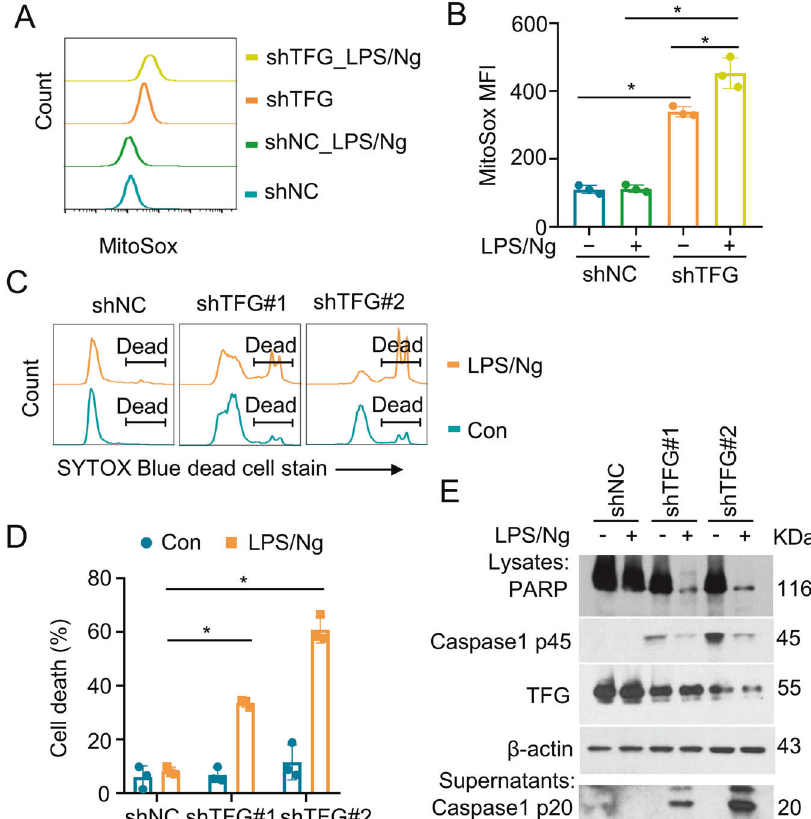
Fig. 1 TFG de fi ciency promotes mitochondrial ROS production and LPS/Ng-induced pyroptosis in THP-1 cells. A THP-1 cells were transduced with a nontargeting control shRNA (shNC) or TFG-speci fi c shRNAs (shTFG#1 and shTFG#2) to obtain TFG stable knockdown cells. Cells were primed with 1 μ g/mL of LPS for 4 h followed by Nigericin (5 μ g/mL) stimulation for an additional 60 min (LPS/Ng). SYTOX Blue Dead Cell staining and fl ow cytometry analysis were performed to analyze cell death. B Scatter dot plots of cell death percentages in groups described in A are shown. Bars represent the mean ± s.d. * p < 0.05; n = 3 for each group. C THP-1 cells were transduced with shNC or shTFG#2 were primed with LPS (1 μ g/mL) for 4 h followed by Nigericin (5 μ g/mL) stimulation for an additional 10 min. Cells were incubated